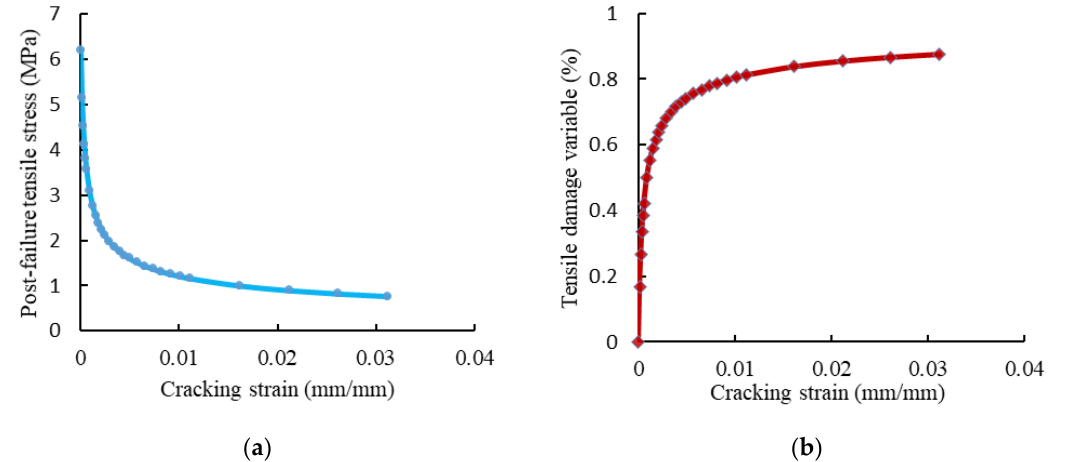
Figure 13. The behavior of concrete under tension. ( a ) Post-failure behavior of concrete. ( b ) Tensile damage evolution of concrete.